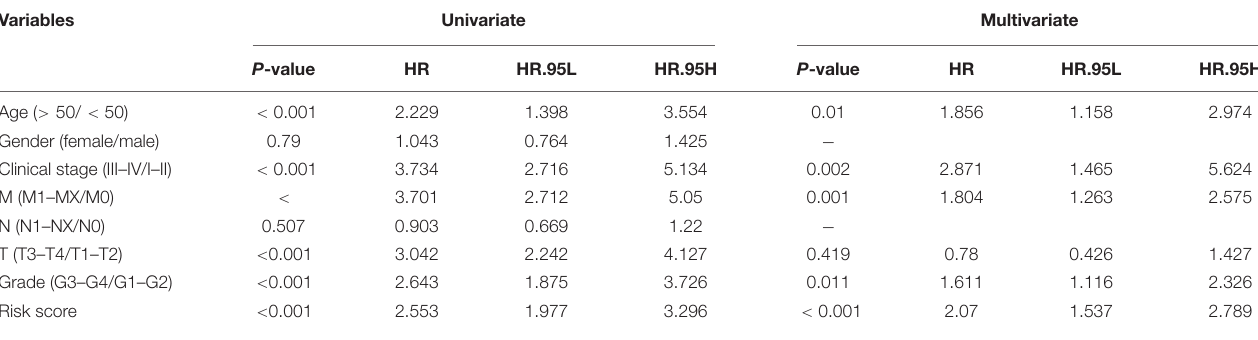
TABLE 2 | Univariable and multivariable Cox regression analyses of clinical